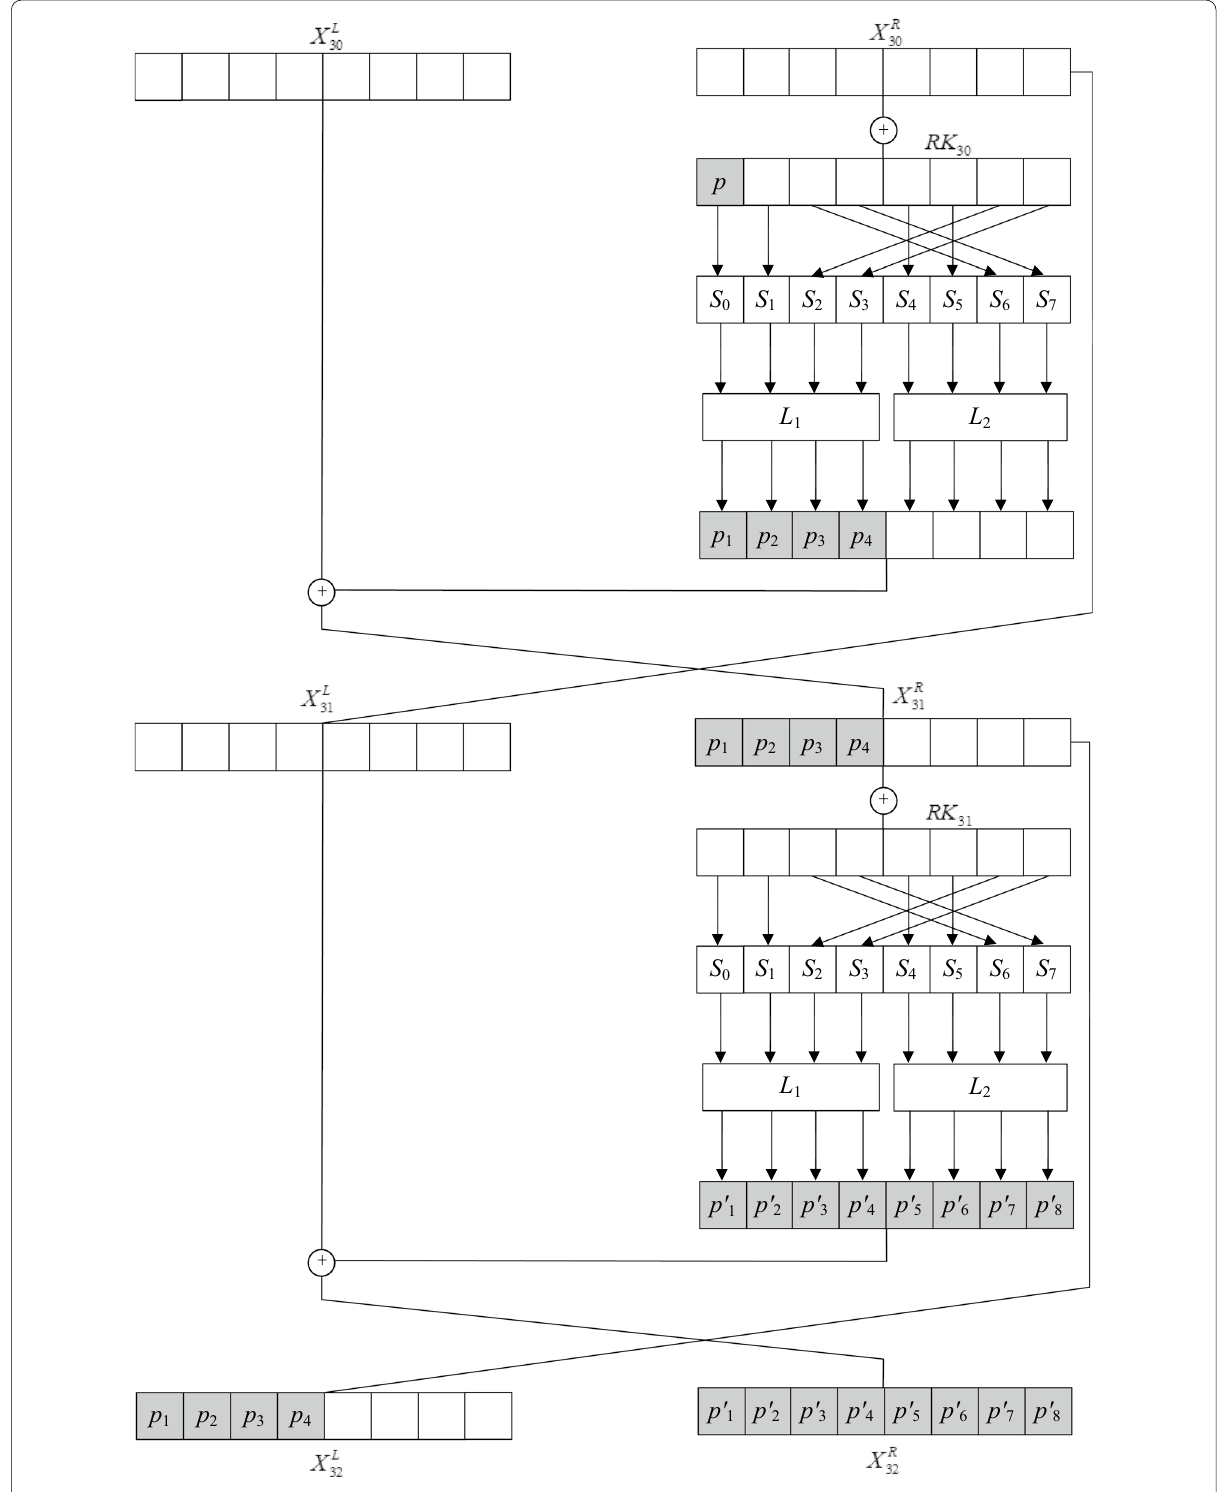
Fig. 4 The fault propagation process on RK 0